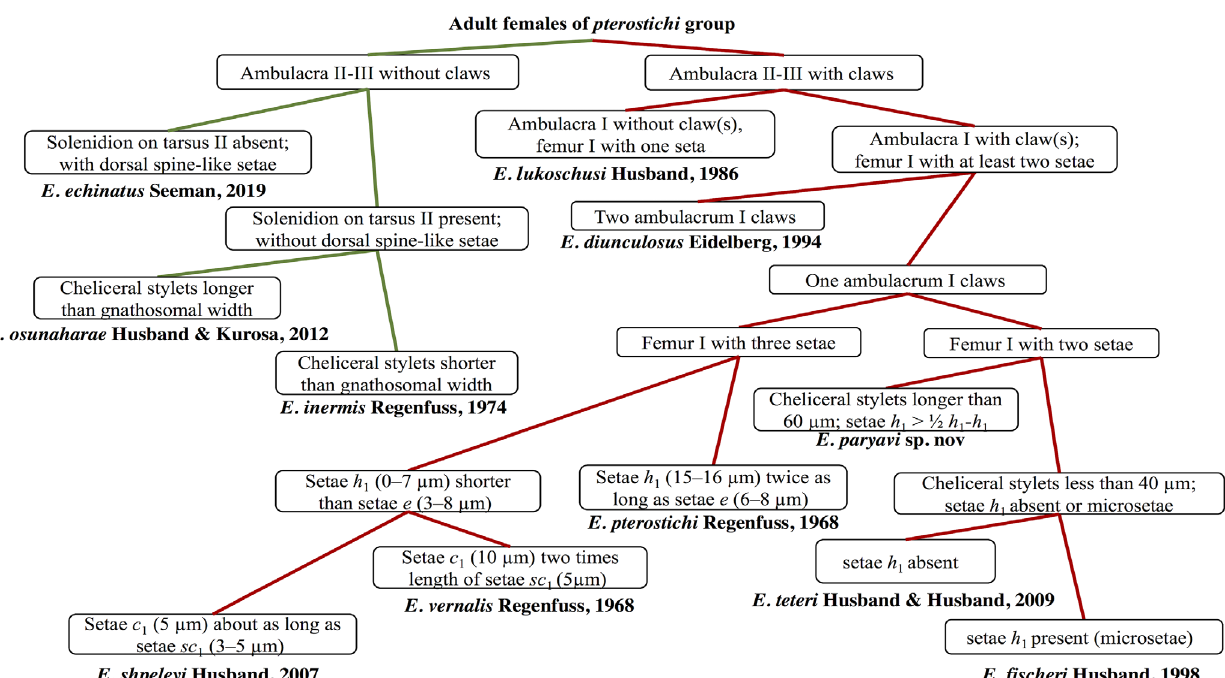
Figure 4. Key to the world species of Eutarsopolipus in the pterostichi group (based on adult females).